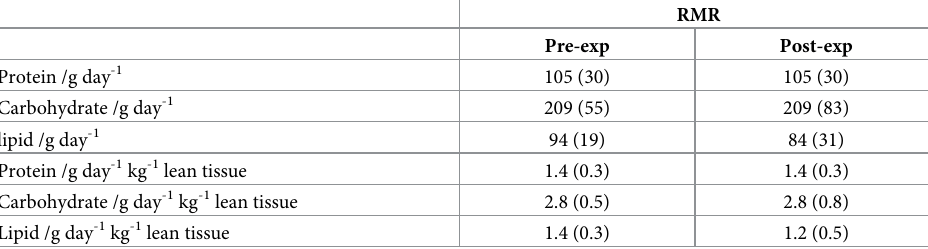
Table 4. Average [median (IQR)] substrate utilisation pre- and post-expedition for the resting metabolic rate (RMR); raw and normalised to lean tissue